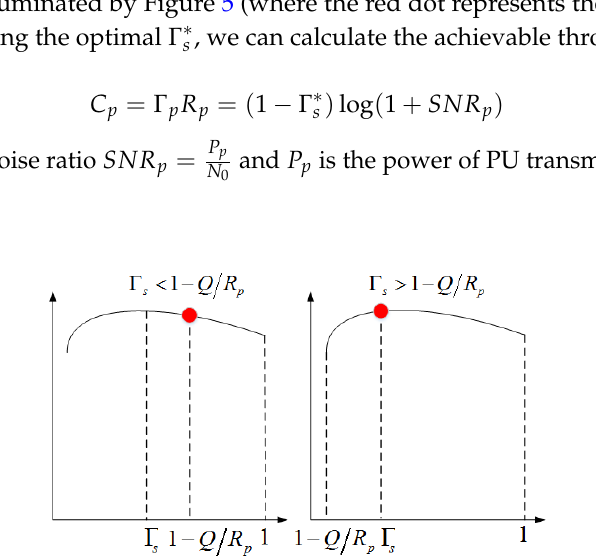
Figure 5. Graphical interpretation for the optimal save-ratio in leasing and energy harvesting transmission